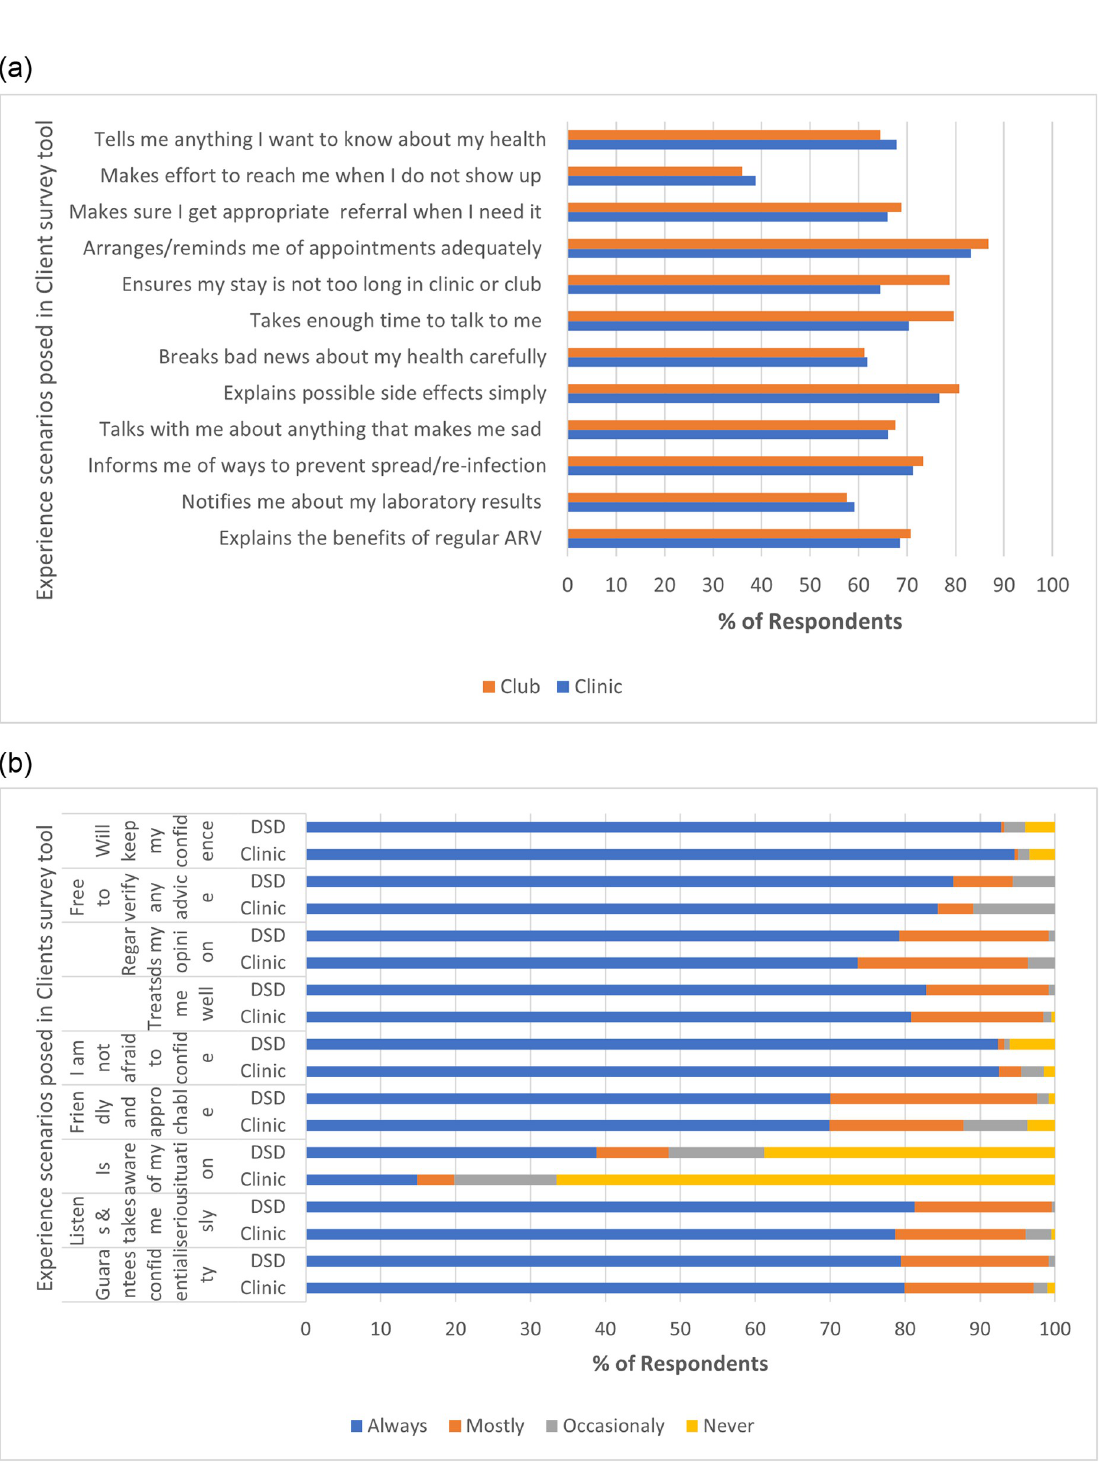
Fig 2. a : Process of care: Clients’ perspective. b : Outcome of care: Clients’ perspective.